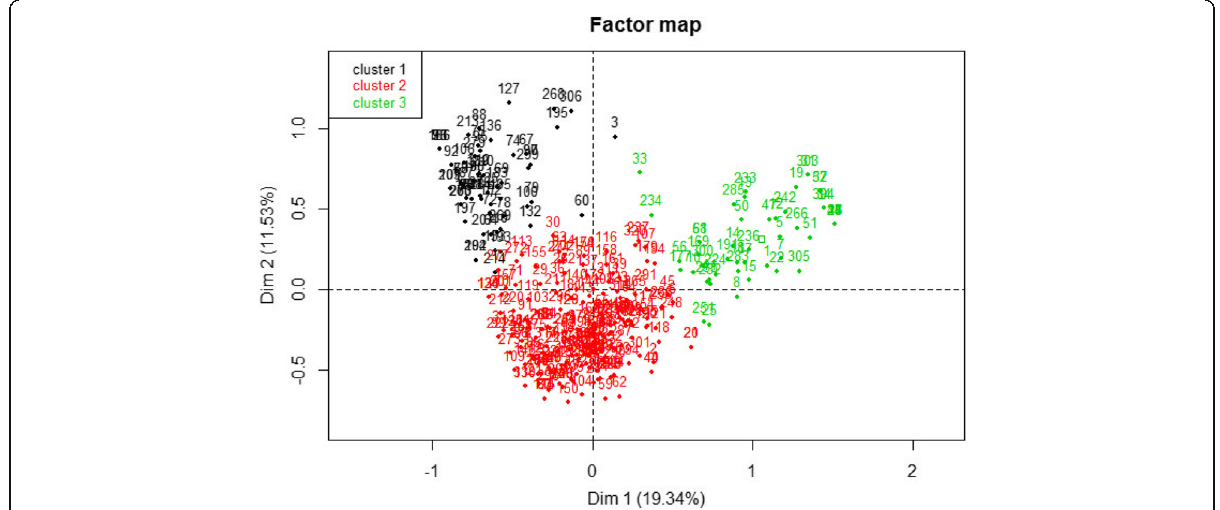
Fig. 4 Graphic representation of the three clusters (numbers correspond to individuals interviewed) on the first two